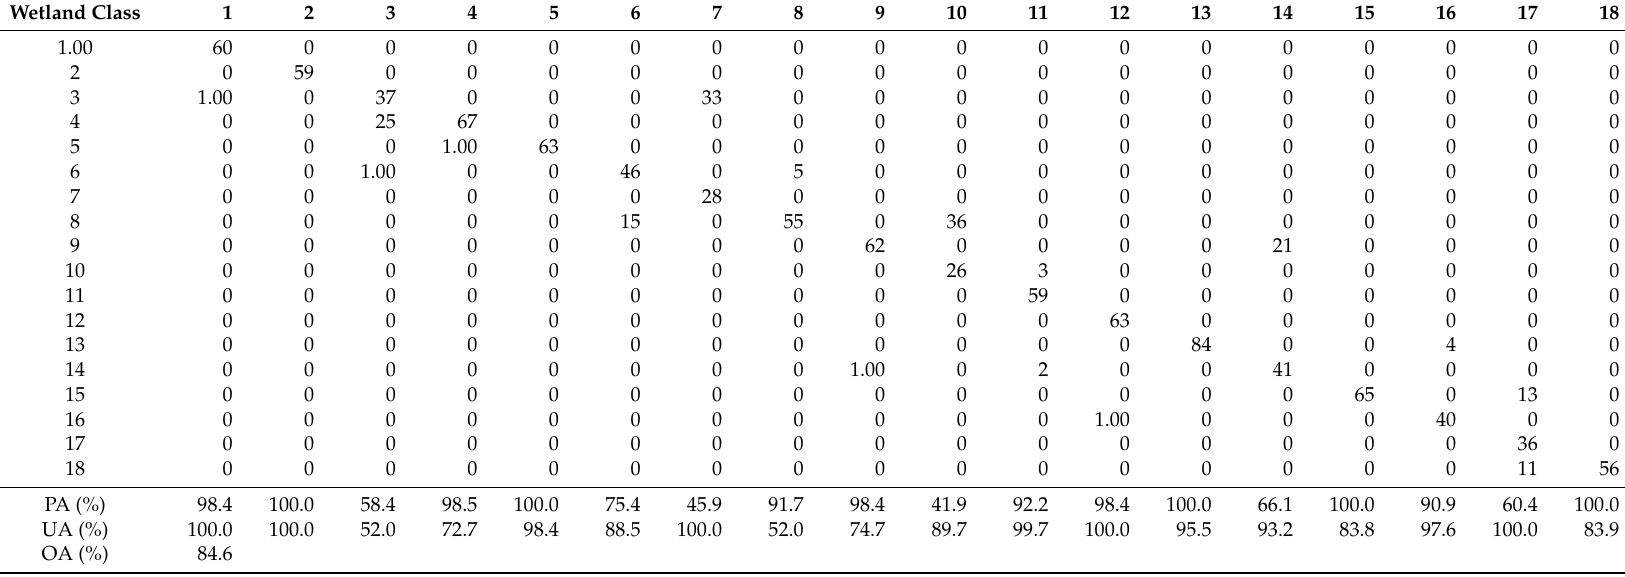
Table 9. Object-based random forest classification (segmentation scale of 5) confusion matrix (pixel-counts) for genus-level wetland classes and aquatic habitats (three-layer stack). PA, UA, and OA are producer’s, user’s, and overall accuracy, respectively. See the legend in Figure 5a for additional information regarding the wetland class community